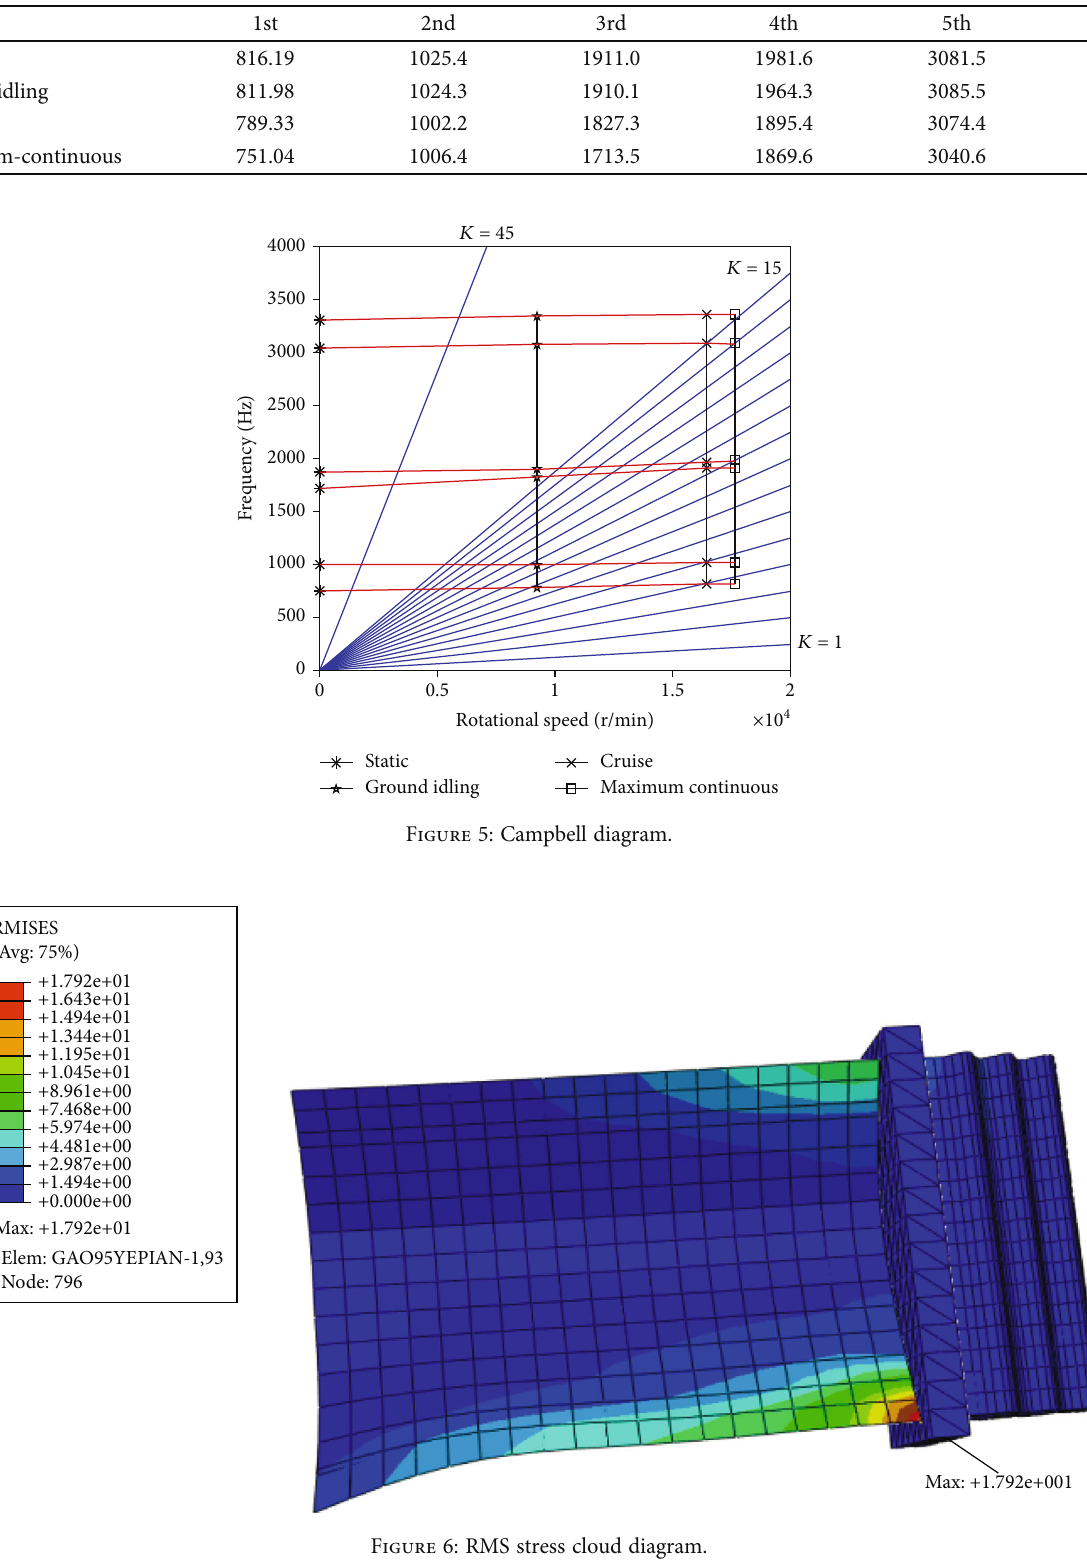
Table 3: Calculation results of turbine blade frequencies.